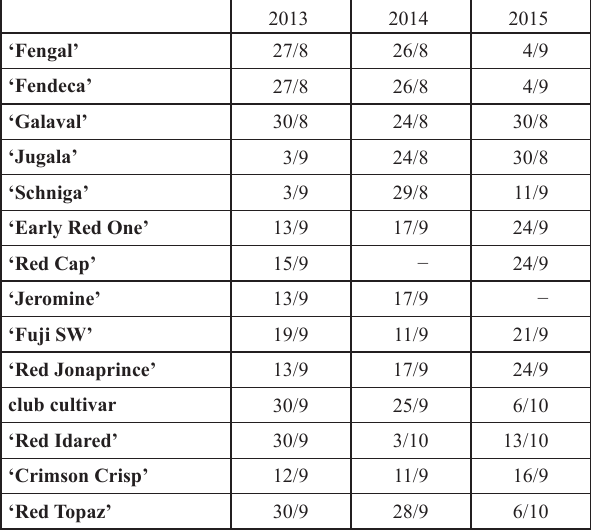
Table 1 : Harvest time of the cultivars (Nyírbátor, 2013-2015).